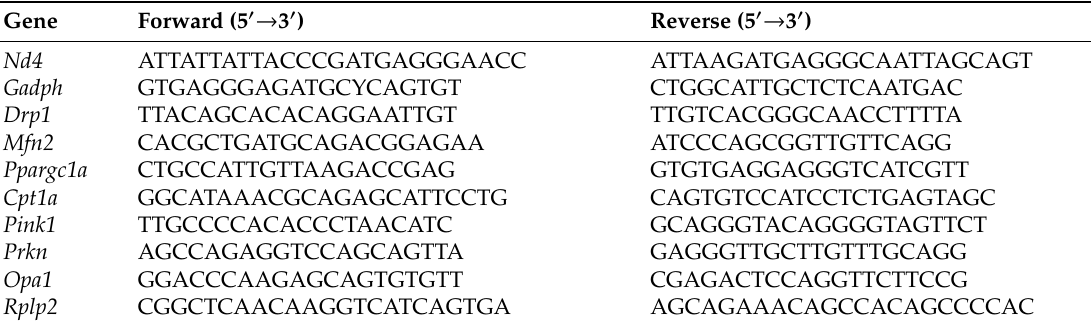
Table 1. List of gene-specific primers for the real-time PCR